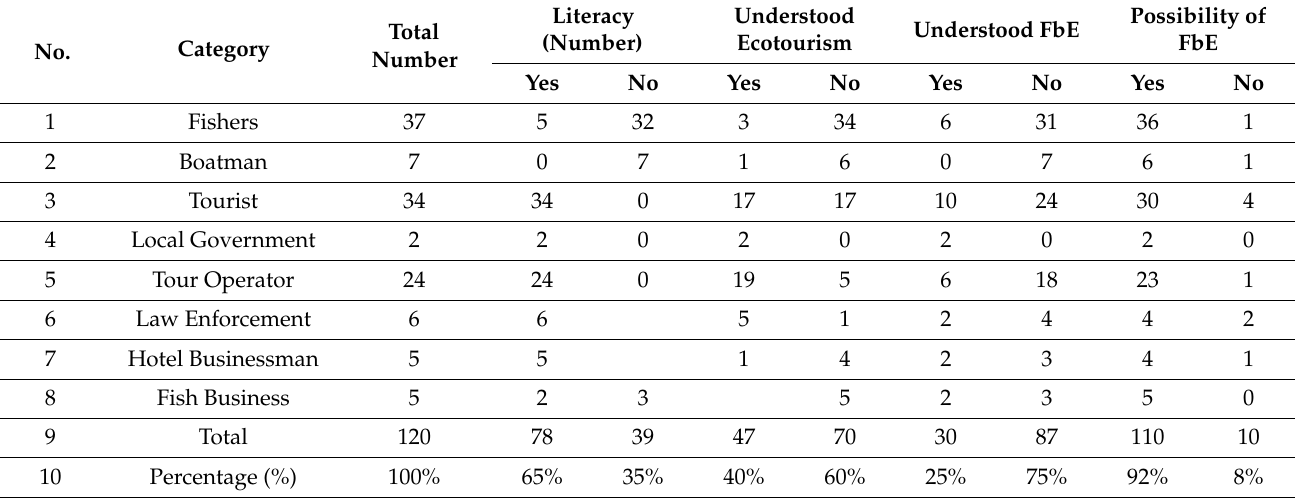
Table 1. Stakeholders’ knowledge of ecotourism and fishery-based ecotourism (FbE).